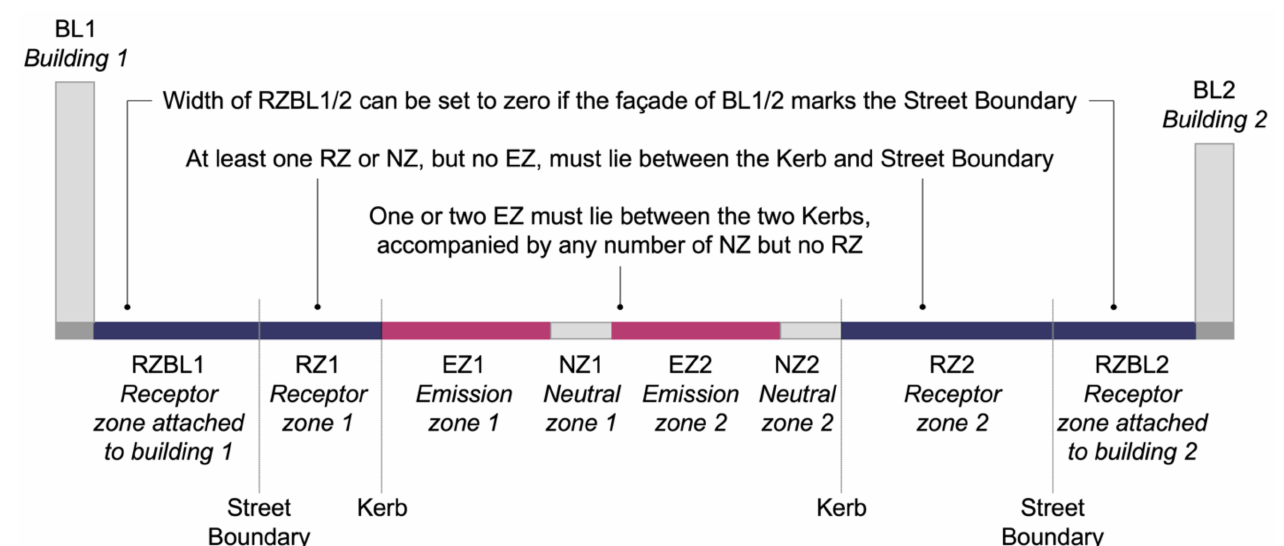
Figure 1. Example street section, dividing and dimensioning the space between the nearest buildings either side of the road (on a line perpendicular to it) into receptor zones (RZ), emissions zones (EZ) and neutral zones (NZ); a wide variety of street configurations are possible, limited only by the constraints described in the figure for compatibility with the air quality